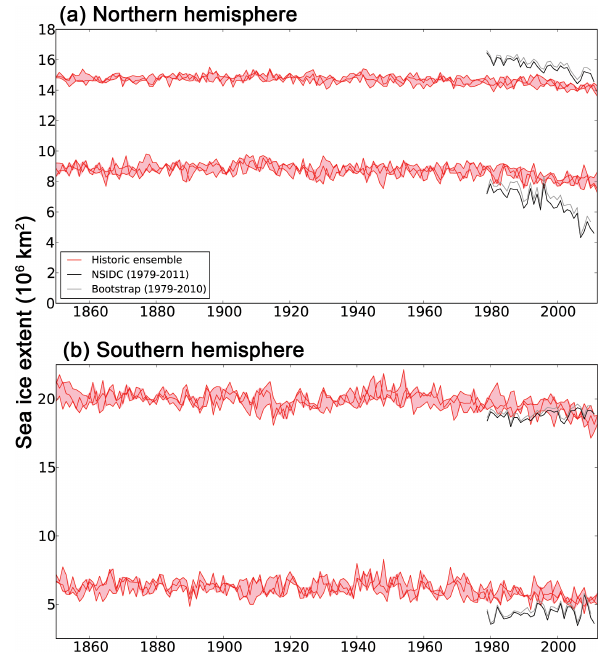
Fig. 25. Time series of (a) Northern and (b) Southern Hemisphere winter and summer sea- ice extent from the historical ensemble (red), and two satellite-based estimates for the sea-ice extent: the Sea-Ice Index in black from NSIDC (Fetterer et al., 2009), and in gray data based on the Bootstrap algorithm (Comiso, 1999).